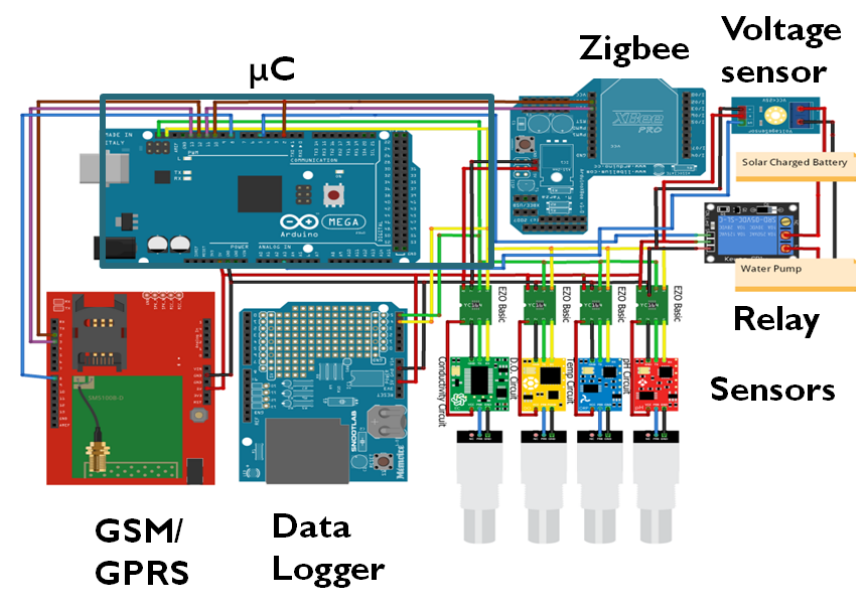
Figure 3. Sense and control unit annotated schematic diagram.